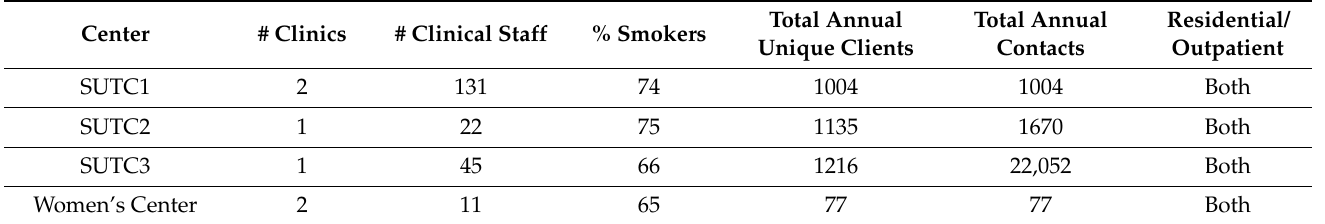
Table 1. Characteristics of participating